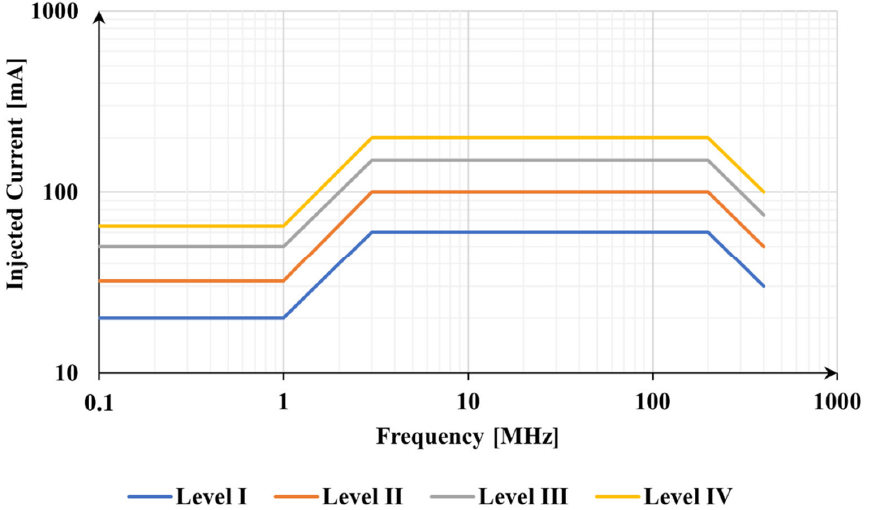
Figure 1. BCI Test profiles according to different severity levels. ISO 11452 ‐ 4 indicates four stress levels applied to the DUT, depending on the required operational characteristics. Injected disturbances, according to ISO 11452 ‐ 1, could be a continuous wave (CW), amplitude ‐ modulated (AM) or pulse ‐ modulated (PM) signal; for AM, the modulation signal frequency is 1 kHz and the modulation index is 0.8 in order to guarantee peak value conservation, typically reported into the test plan as AM, 1 kHz 80%, modulated signal is reported in Figure 2.